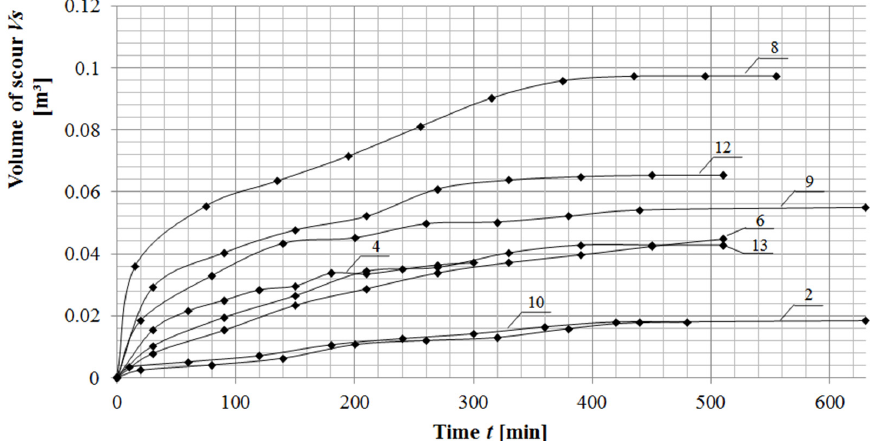
Figure 8. Amount of bedload scattered from the dissipation basin (sandy bed) in variants with invisible scour during test runs No 1, 3, 7, 11; Where 1–13 are the numbers of the measurements (compare with Tables 1 and